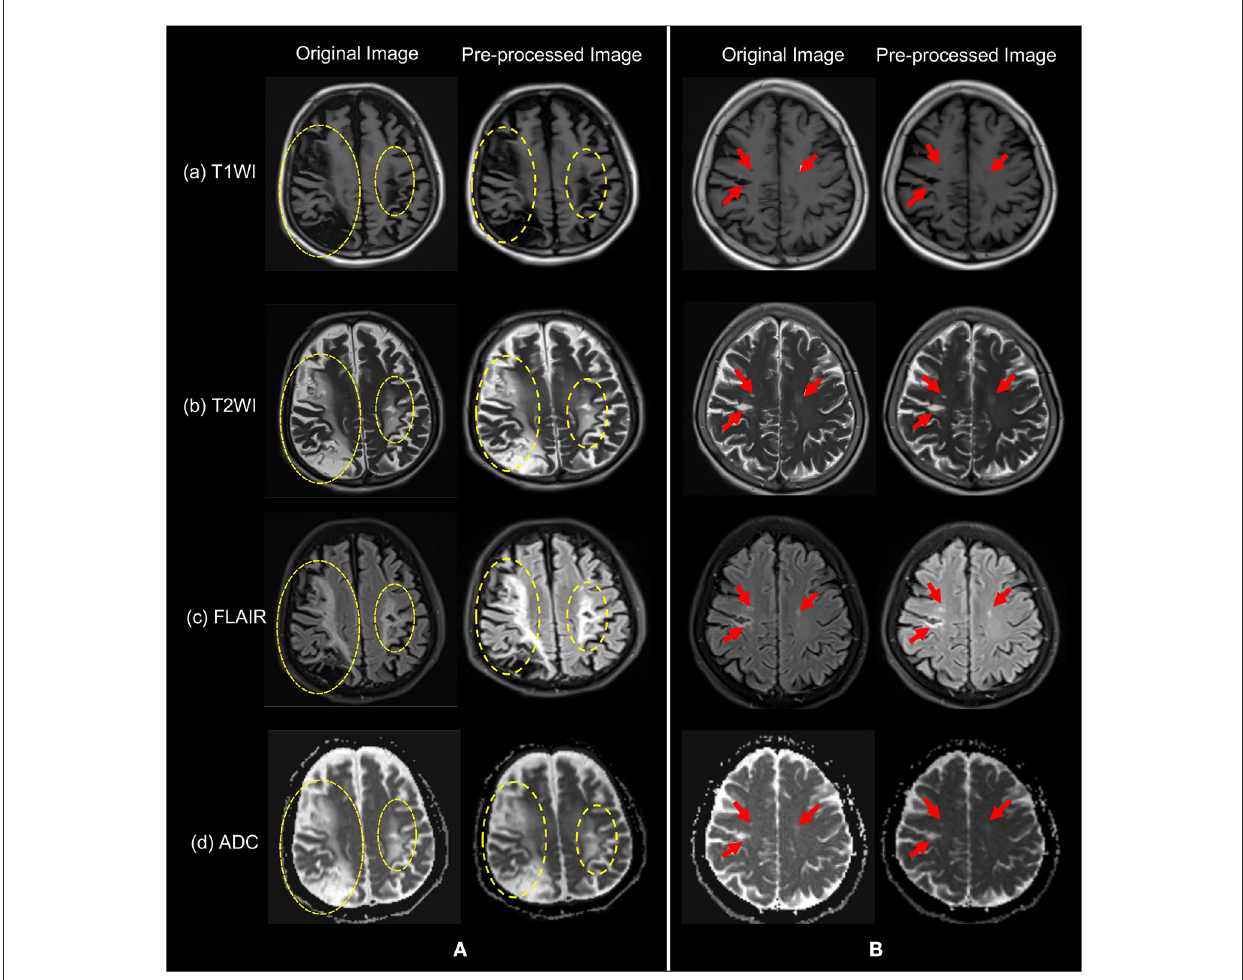
FIGURE3 The original images of the four modalities in (a) T1WI, (b) T2WI, (c) FLAIR, and (d) ADC, and their pre-processed images. Patients in group (A) have yellow dashed circles indicating symptomatic areas and patients in group (B) have red arrows indicating symptomatic areas. Note that visually, symptoms in (A) are more obvious.